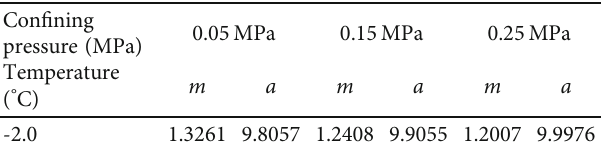
Table 4: Shape parameter and scale parameter solutions (method 2).